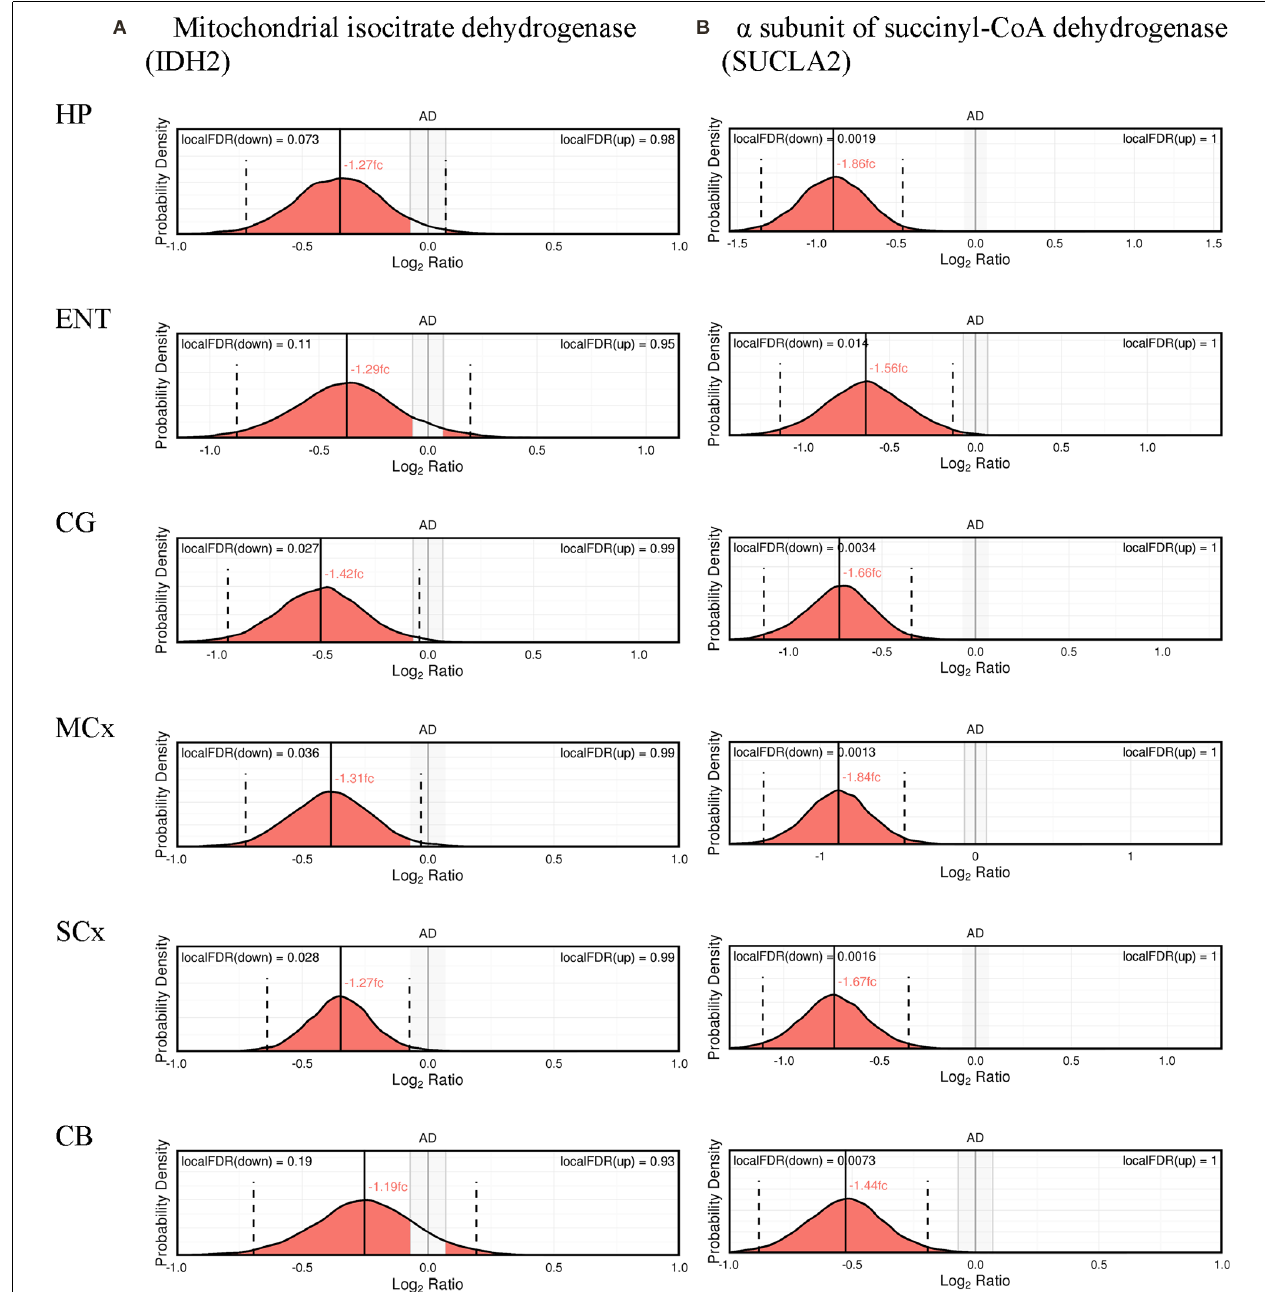
in Table 3 . The different components of an exemplary expression probability distribution diagram are shown in Supplementary Figure 1 for guidance. Each plot shows the probability distribution along with the most likely mean-expression ratio, and the calculated local false-discovery rate (FDR) for each protein molecule that had a differential expression between cases and controls of at least 5%. Shown in Supplementary Figures 2 , 3 are the Bayesian probability distributions for the estimated levels